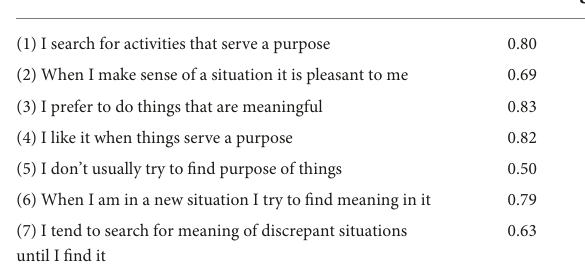
TABLE 2 Standardized factor loadings based on confirmatory factor analysis for seven items of the Need for Sense-Making Scale ( N = 287, Study